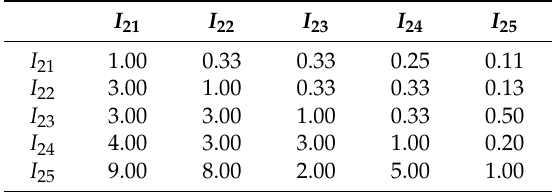
Table A3. Judgment matrix of the planning process index.